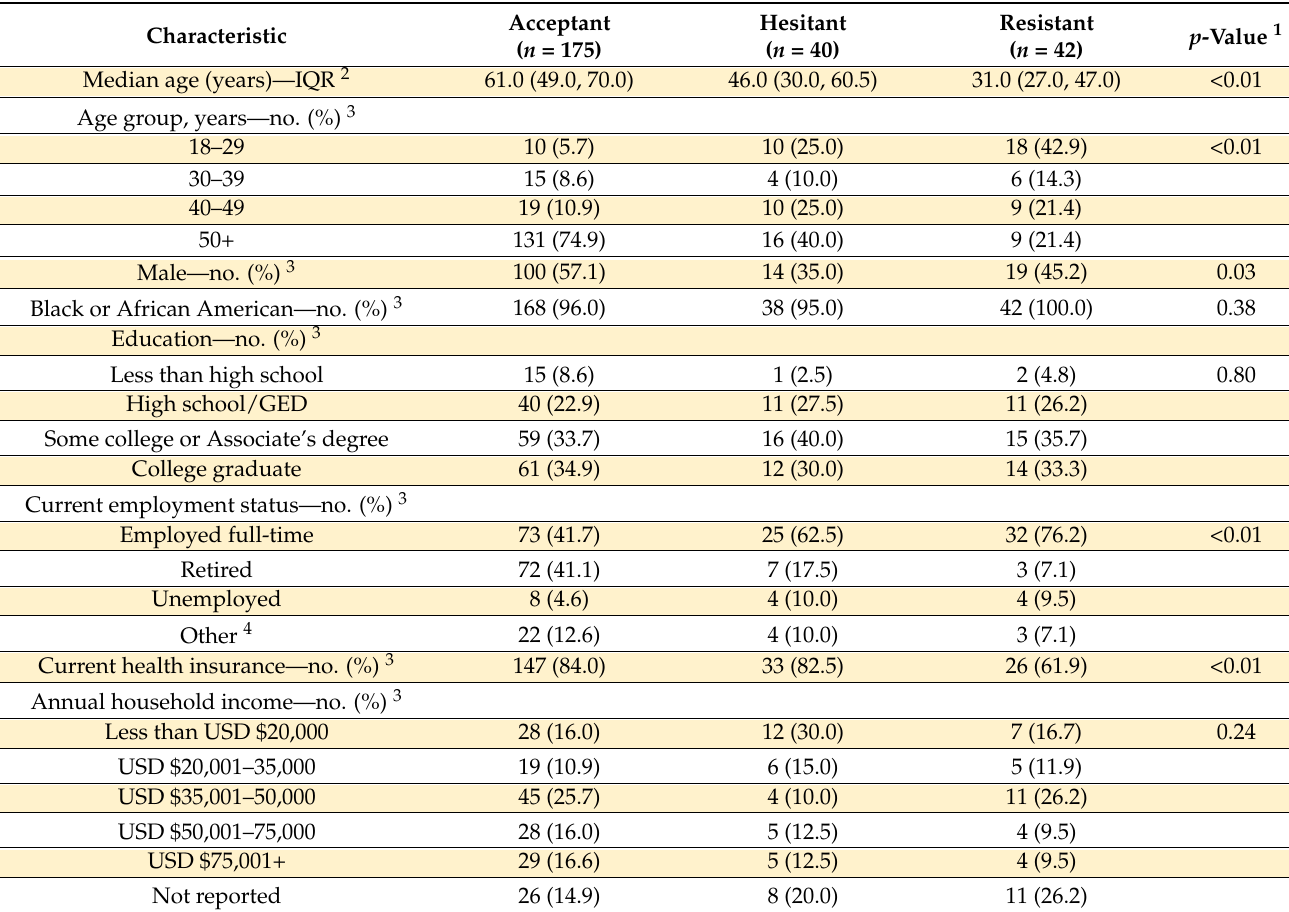
Table 1. Sociodemographic characteristics among 257 community participants within the SPARTA and 100 Black Men of Augusta survey by vaccine hesitancy